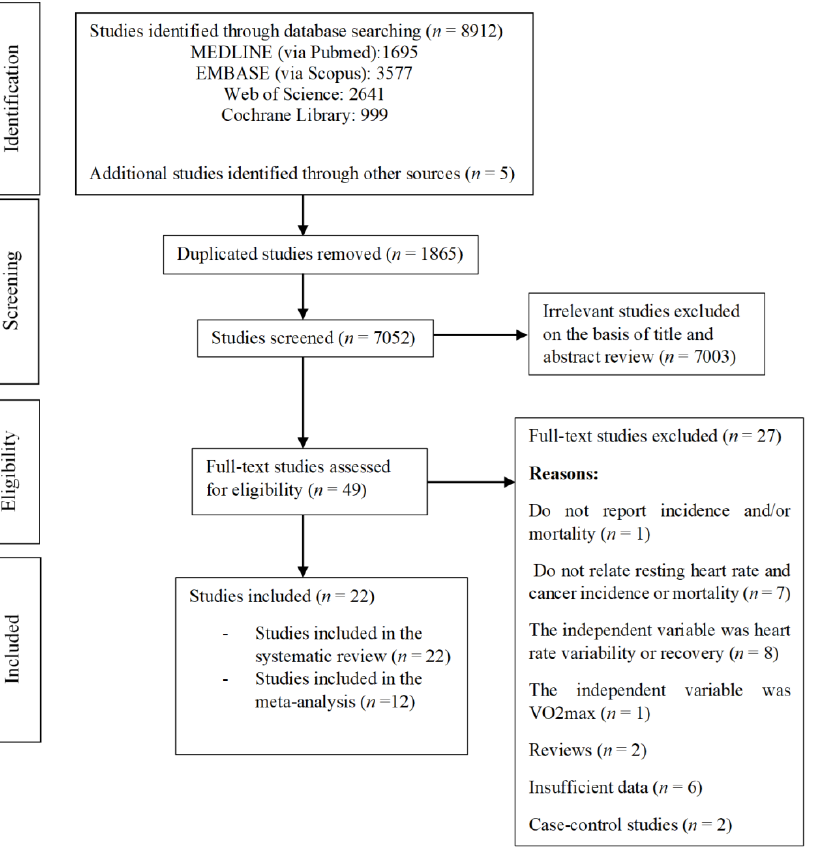
Figure 1. Literature search: Preferred Reporting Items for Systematic Reviews and Meta-Analyses (PRISMA) consort dia- gram.